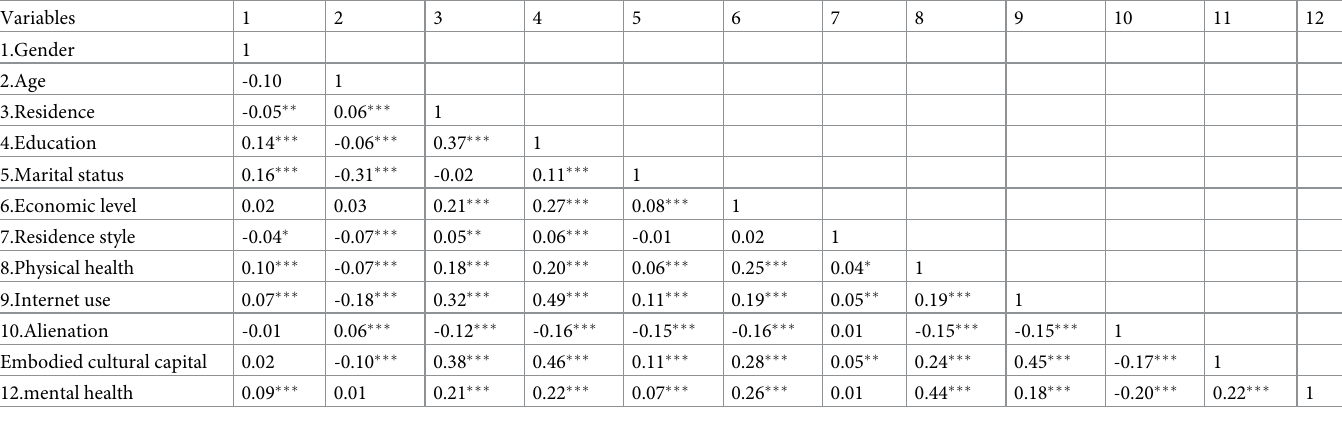
Table 3. Correlation coefficient matrix of main